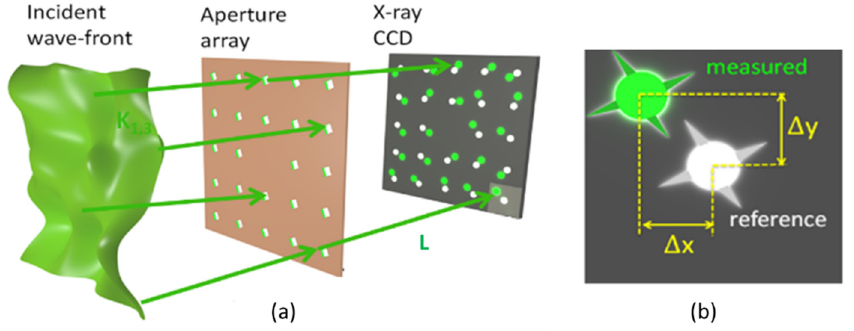
Figure 1. ( a ) Schematic representation of the incoming aberrated wave (in green), going through the Hartmann plate and reaching the detector. ( b ) The white dots correspond to the diffraction spots when a perfect beam reaches the detector, while the green dots correspond to an unknown beam. Courtesy of Dr. Li Lu.